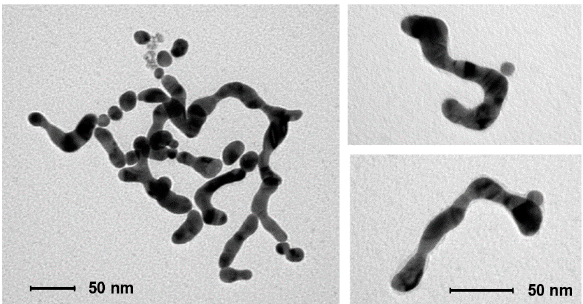
Figure 7. TEM image of the material collected from a solution of AuNPs after NaCl-induced linear aggregation and subsequent addition of H 2 O 2 . Nanowires were obtained without adding GAP.